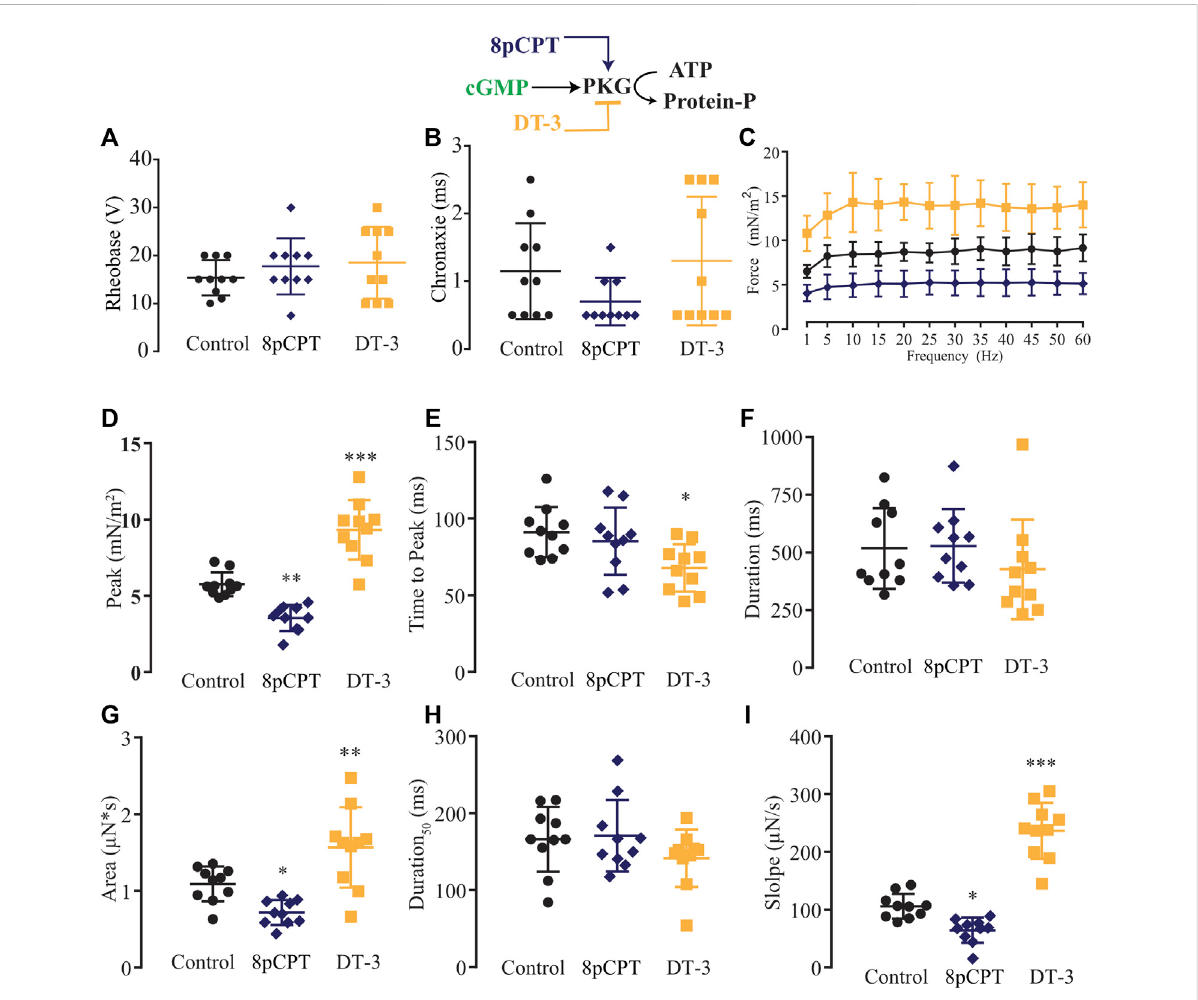
FIGURE 6 Summary of the effect of 8-pCPT and DT-3 on PKG role in myooid response to electrical stimulation. Myooids perfused with control solution arerepresentedbytheblackcolor,darkblueformyooidstreatedwithPKGactivator8-pCPT,andgoldcolorforthosetreatedwithPKGblockerDT-3. (A) Rheobase and (B) Chronaxie summarized the excitability of the myooids under subthreshold stimulation. (C) Force frequency protocol. (D – I) analyses of the biophysical parameters in response to single-twitch stimulation. Each condition contained ten myooids and the symbols *, **, and *** represent the signi fi cant thresholds below 5%, 1%, and 0.1%,